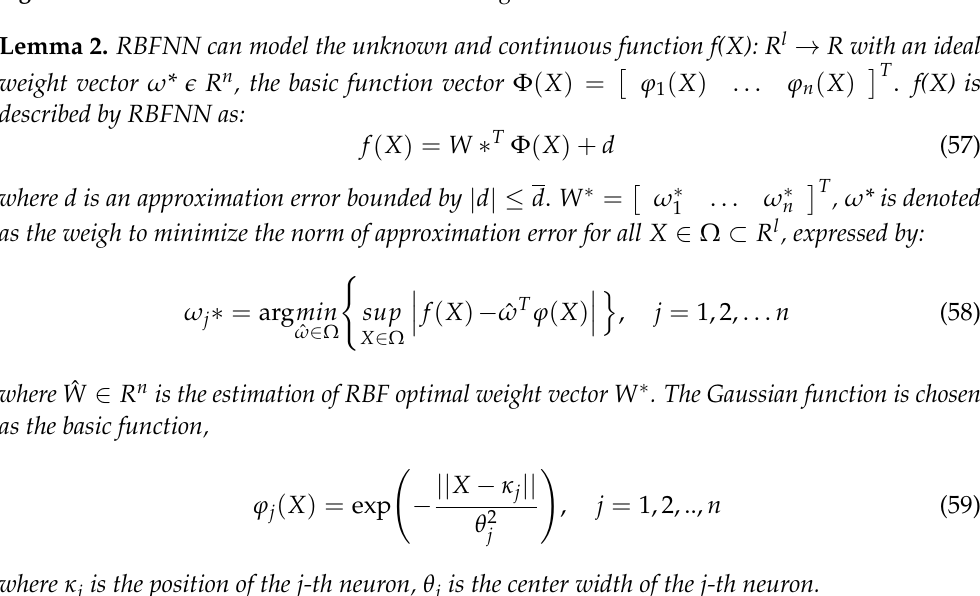
Figure 2. RBFNN estimation control schematic